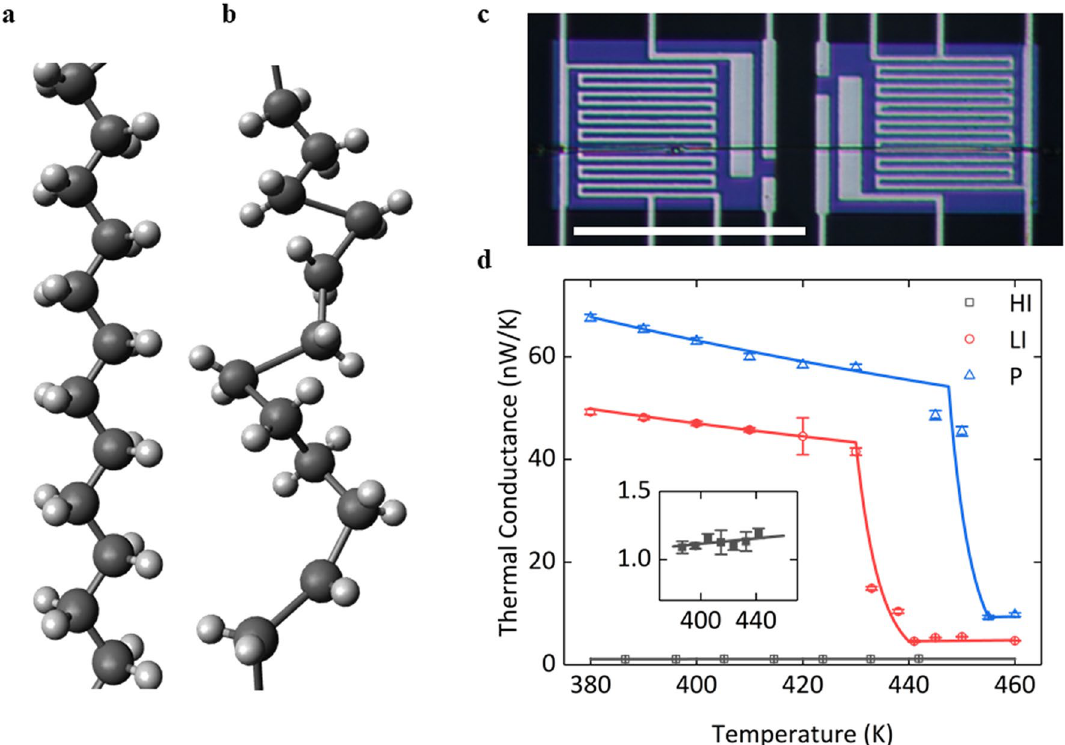
Figure 1. Schematics of a PE molecular chain ( a ) before and ( b ) after phase transition. The molecular chain shows the rotational disorder after phase transition. ( a ) and ( b ) created by Avogadro, version 1.2.0n, https ://avoga dro.cc/. ( c ) Optical image of a PE nanofiber on a suspended platinum resistance thermometer microdevice. Scale bar, 50 μm. ( d ) Our previous experimental data and theoretical fitting curves of the temperature-dependent thermal conductance of pristine (P), lightly-irradiated (LI) and heavily-irradiated (HI) PE nanofibers. The inset figure shows the linear fitting of experimental data for the HI PE